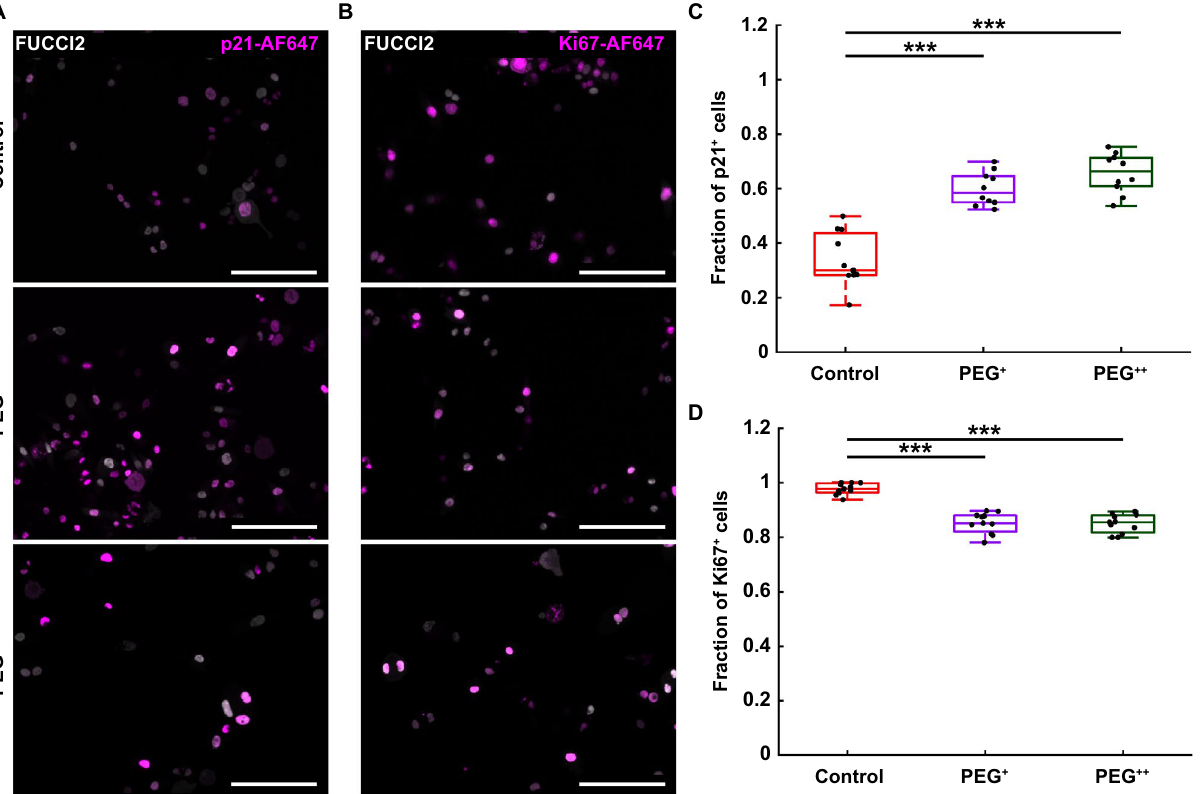
Figure 4. Osmotically-driven delayed or growth-arrested cells show a higher expression of p21 and lower expression of the proliferation marker Ki67. ( A ) p21 immunofluorescence (magenta, AF647) overlaid with FUCCI2 fluorescent cells (artificially indicated as white) for the control, PEG + and PEG ++ groups, at 90 h time point. Scale bars are 200 µm. ( B ) Ki67 immunofluorescence (magenta, AF647) overlaid with FUCCI2 fluorescent cells (artificially indicated as white) for the control, PEG + and PEG ++ groups, at 90 h time point. Scale bars are 200 µm. ( C ) Fraction of p21 positive cells on three biological repeats and N = 10 wells. ( D ) Fraction of Ki67 positive cells on three biological repeats and N = 10 wells. The plots represent the median, 1st and 3rd quartiles and extrema. Statistical analysis with respect to the control using a two-tailed Wilcoxon rank sum test, n.s: p > 0.05, *: p < 0.05, **: p < 0.01 and ***: p <